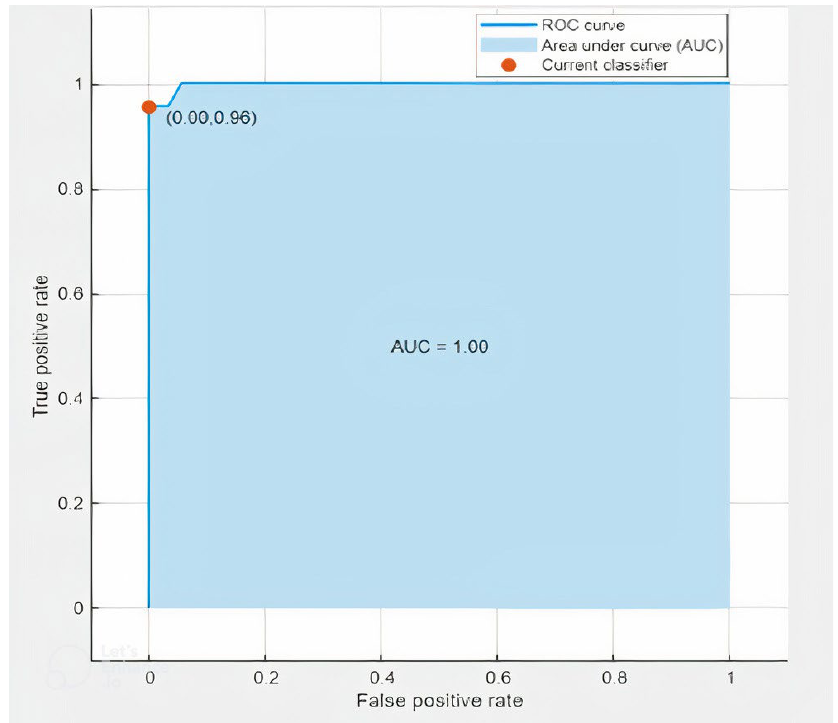
Figure 18. ROC Curve of Softwood, Average Tool, 3 mm.